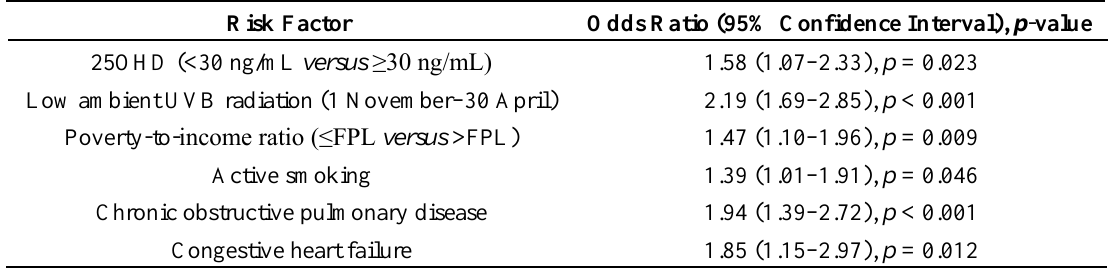
Figure 1. Near linear relationship of acute respiratory infection and 25-hydroxyvitamin D up to 30 ng/mL in LOWESS analysis. Locally weighted scatterplot smoothing analysis = LOWESS; 25OHD = 25-hydroxyvitamin D in 10 ng/mL increments; ARI = acute respiratory infection. Table 2. Multivariable model with odds ratios for acute respiratory infection risk